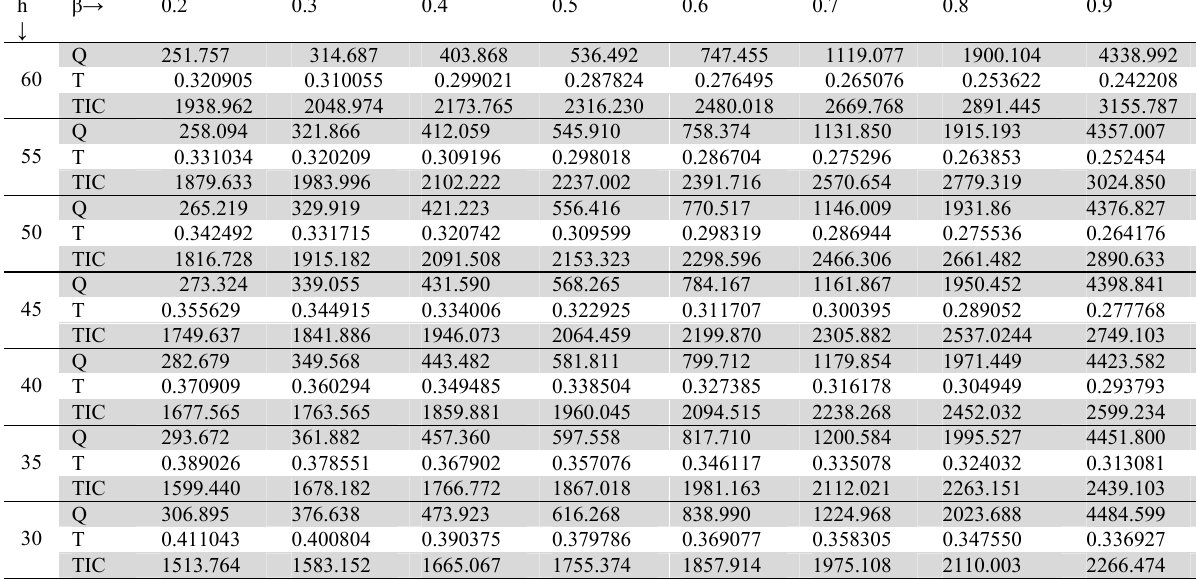
Variation of optimal solution of Q = Q keeping all the parameters same as in Example 1.